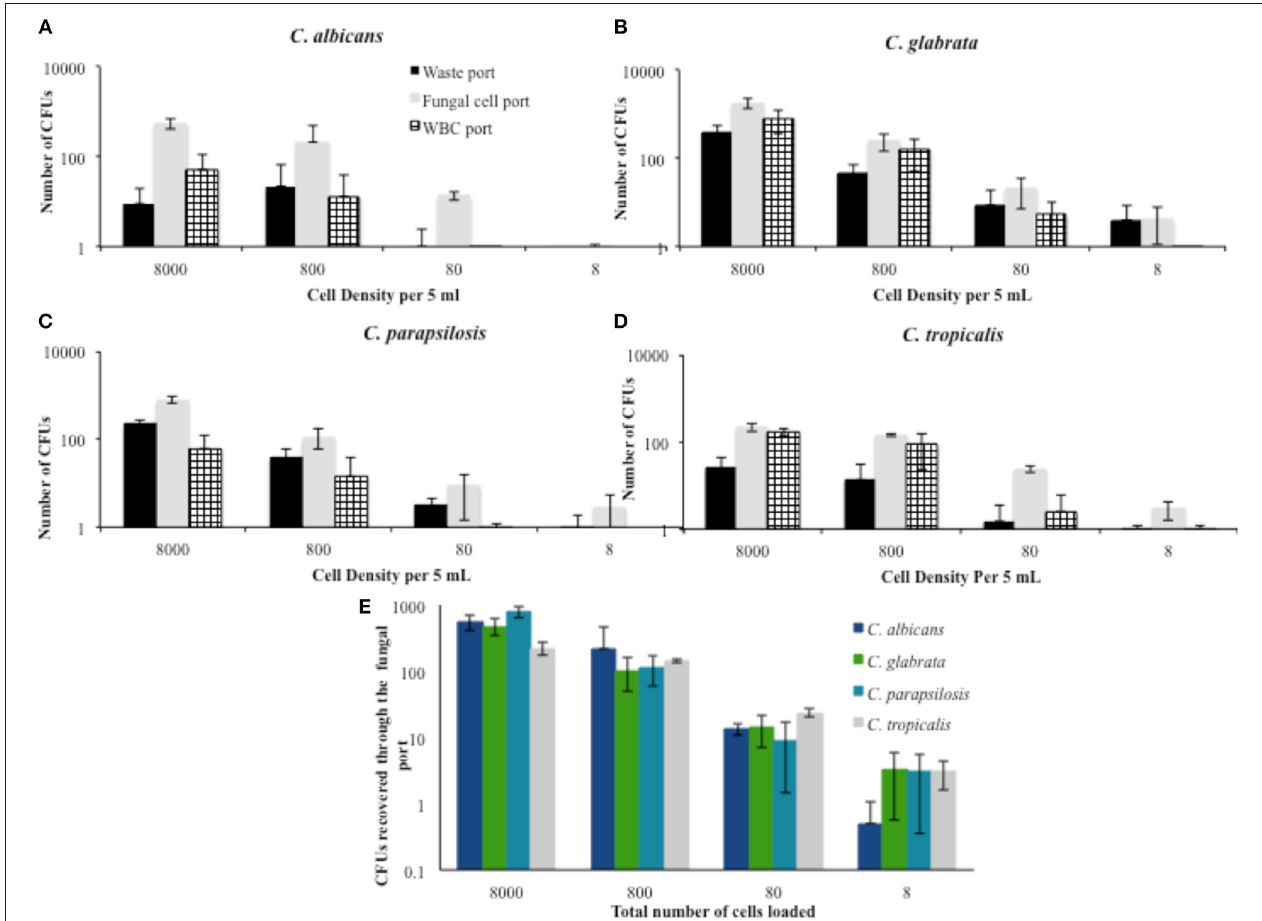
FIGURE 2 | Percent distribution of fungal cell migration at different cell densities in PBS solution . The portion of fungal cells directed to the waste port, fungal cell port, and WBC port were determined for the most commonly encountered fungal species. (A) C. albicans (B) C. glabrata (C) C. parapsilosis, and (D) C. tropicalis . (E) A summary of the recovered cells from the fungal cells port is provided as a comparison between the tested Candida spp. Error bars indicated standard